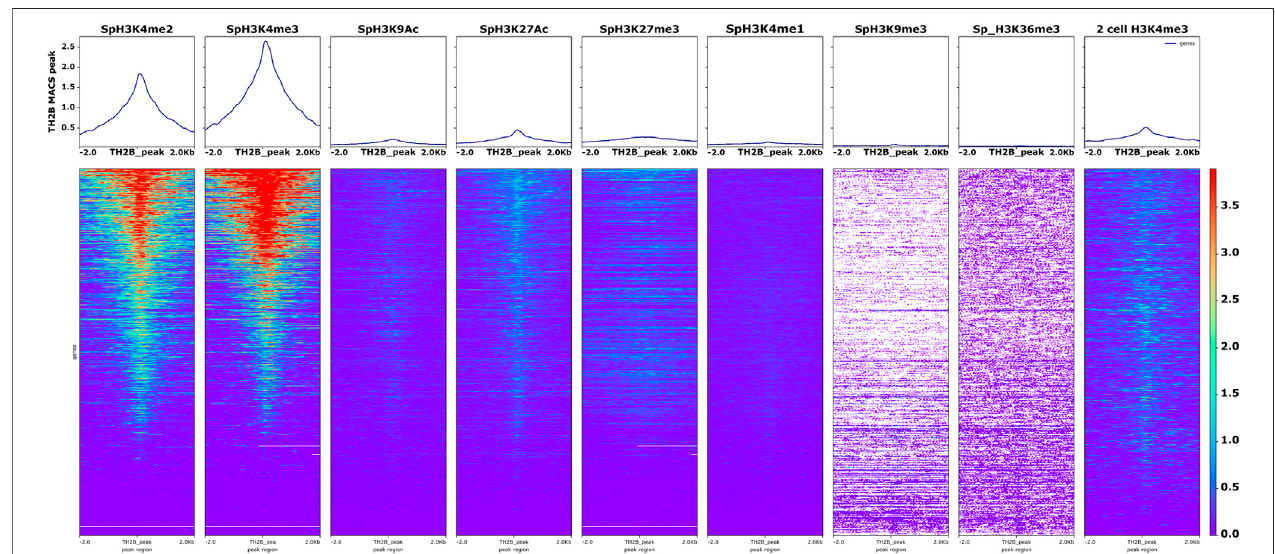
FIGURE 8 | Mature sperm-retained TH2B-associated loci overlap with activating modi fi cations H3K4me3/H3K4me2 in sperm and two-cell embryos but not with the repressive marks in sperm. Heatmap and pro fi le plot for various sperm-associated modi fi ed histones and their overlap with reference to TH2B MACS2 peak. Scale on the right-hand side reveals the intensity of overlap scores between the query set (TH2B BED) and sperm PTMs.